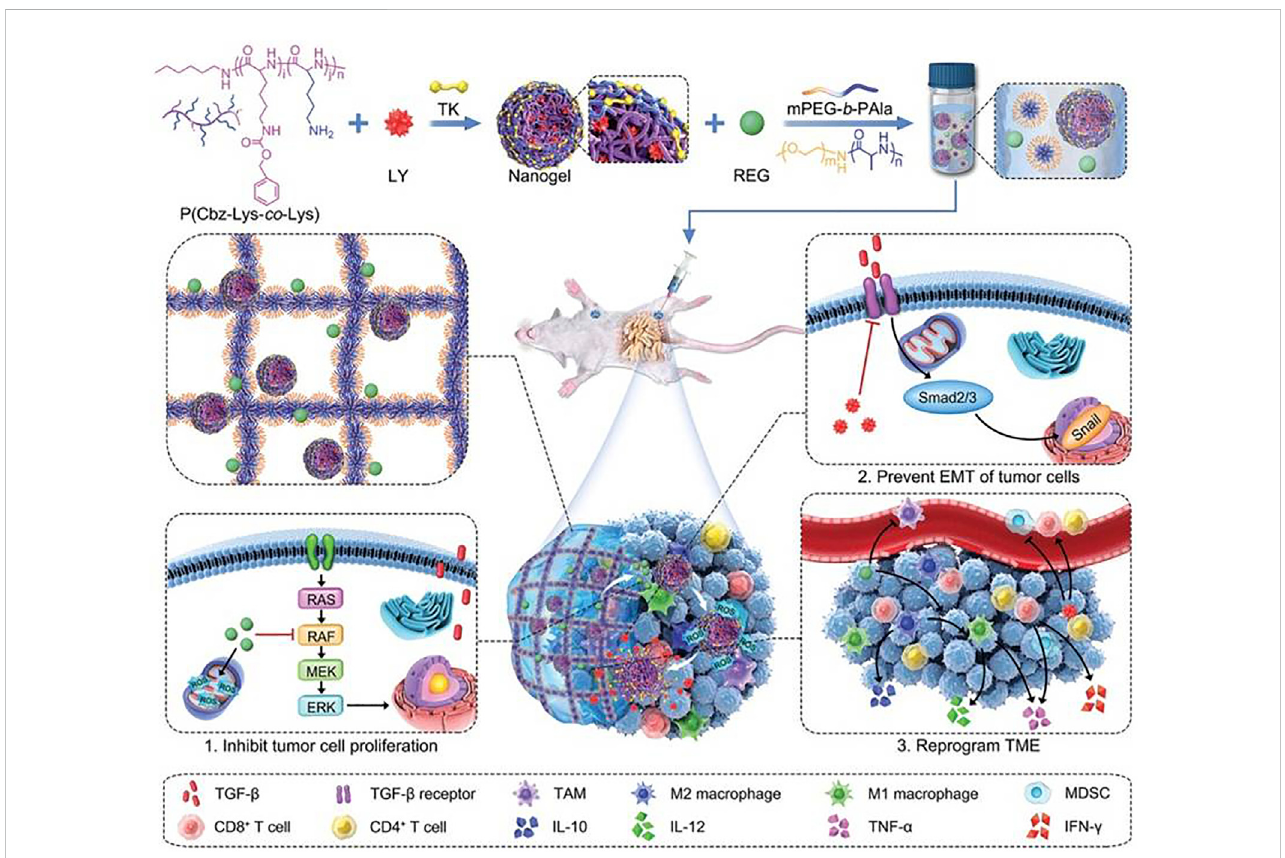
FIGURE 3 Schematic illustration of preparation and in vivo antitumor effect of Gel/(REG + NG/LY). Reproduced from Li et al. (2022), with permission from Wiley- VCH Verlag GmbH & Co. KGaA,